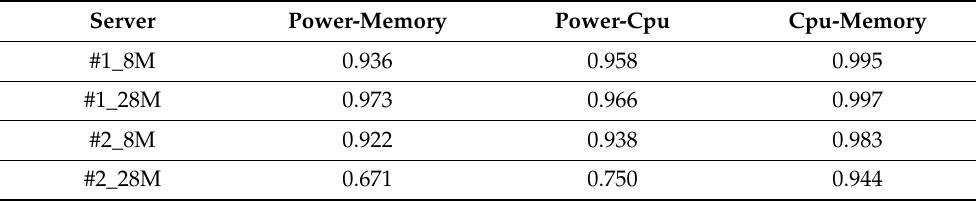
Figure 8. Power and completion time of NAMD. Table 4. Correlations among power, memory, and CPU utilization running NAMD.